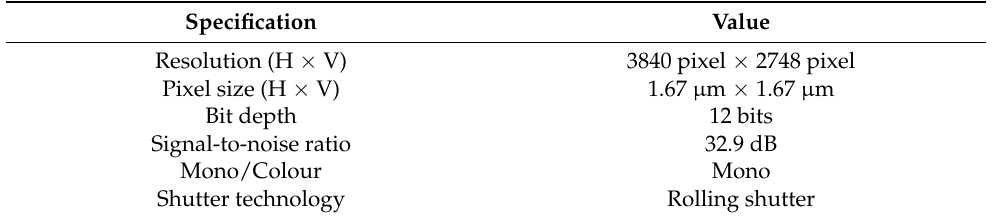
Table 2. Specifications of the used industrial camera Basler